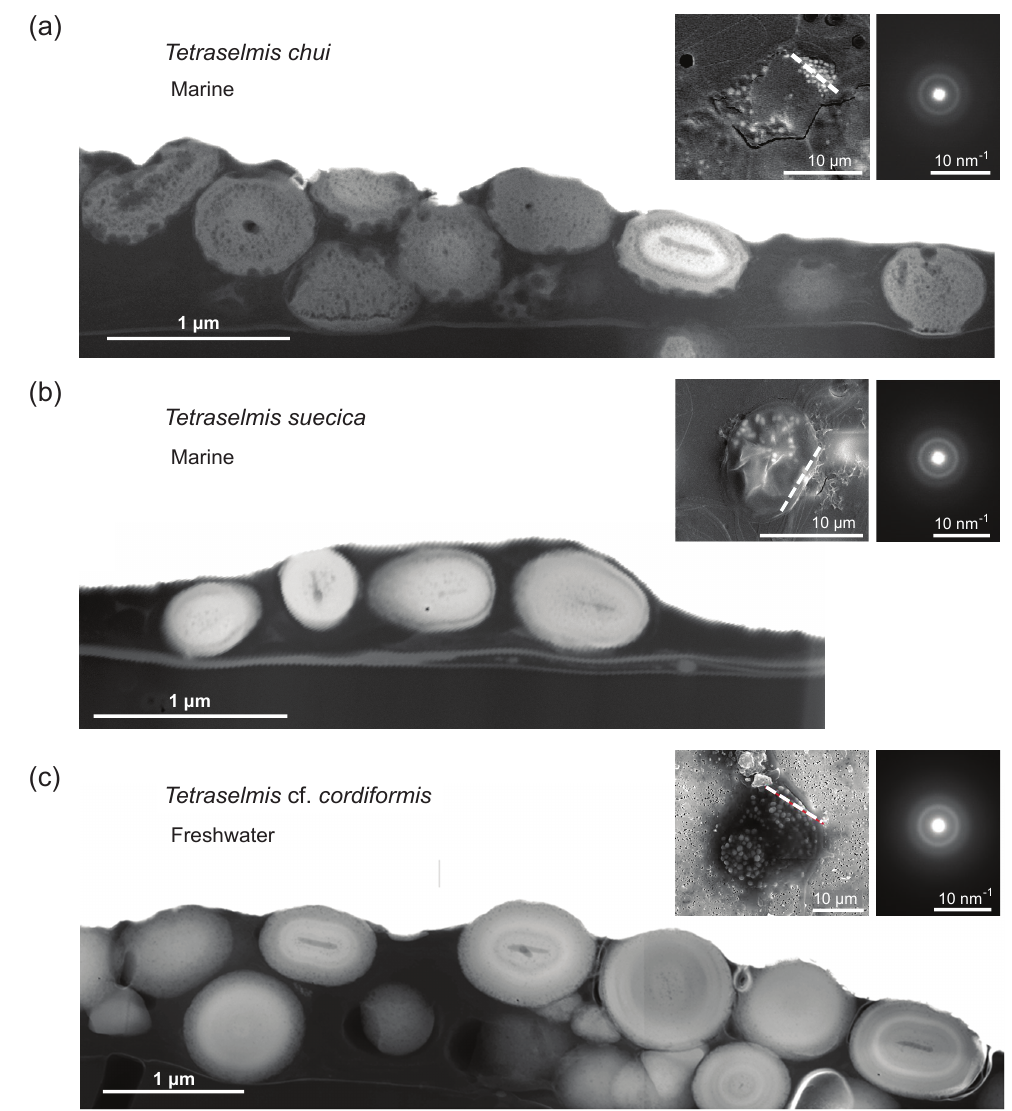
Figure 2. Comparison of FIB-cut sections of cells of three different Tetraselmis species (dried samples). TEM–HAADF images: FIB-cut sections through cells of (a) Tetraselmis chui (culture sample), (b) Tetraselmis suecica (culture sample) and (c) Tetraselmis cf. cordiformis (Lake Geneva) (Martignier et al., 2017). Small bubbles inside the micropearls (particularly visible in the marine species) are due to beam damage. The contact between the cell and the filter surface is visible near the bottom in each image. Left top insets: SEM secondary images of the whole cell before FIB preparation indicating the location of the cut with a dashed line. Right top insets: SAED patterns from a single micropearl of each FIB-cut section (broad diffraction rings are indicative of amorphous